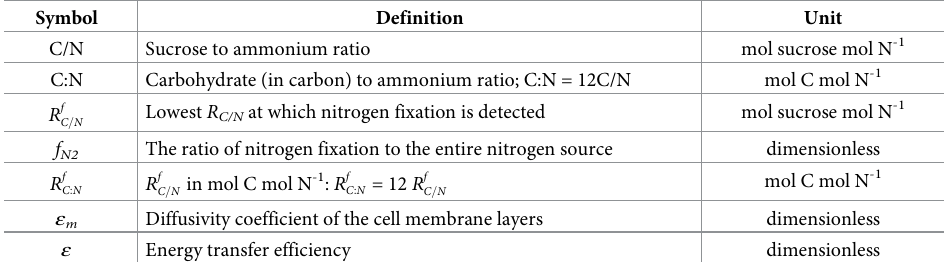
Table 1. Nomenclature of the used symbols in this main text. They are listed roughly in the order of appearance.